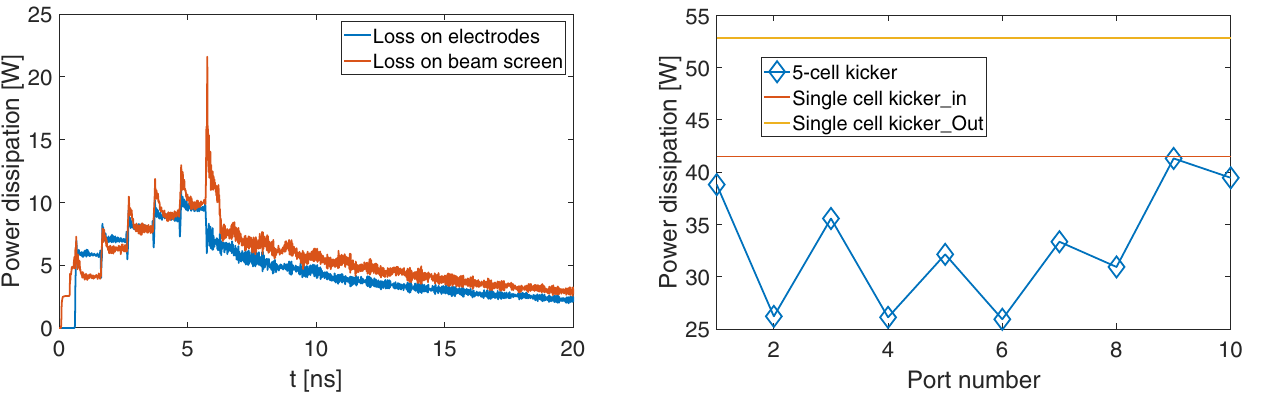
FIG. 4. Power dissipation on the electrodes and the beam screen during and after the bunch passage with bunch charge of 1 nC.